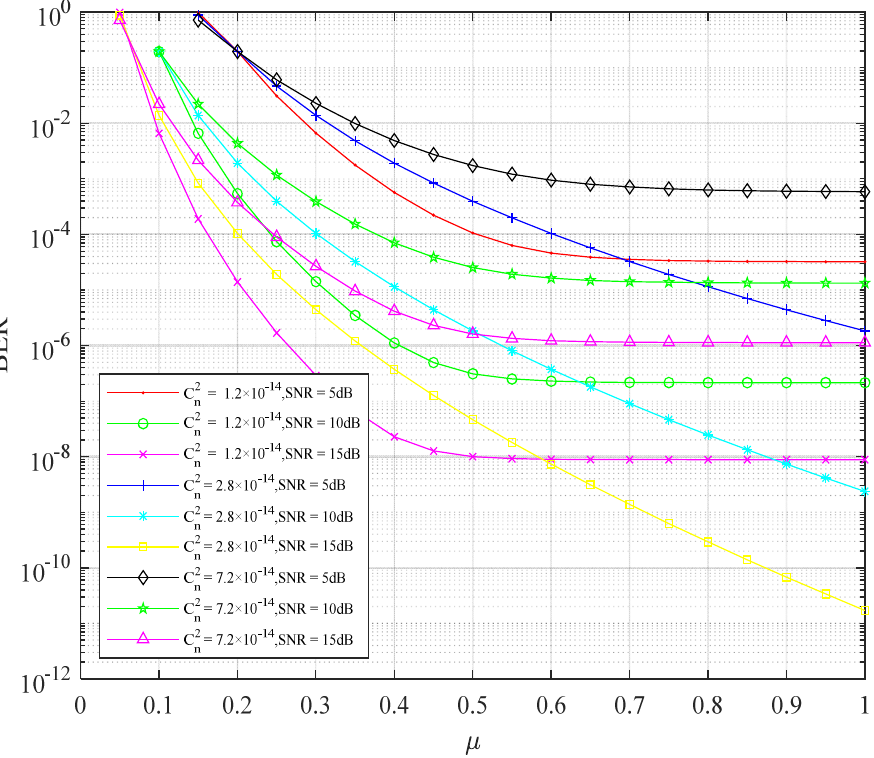
Figure 5. Comparison of system BER performance under different channel asymmetric parameters.